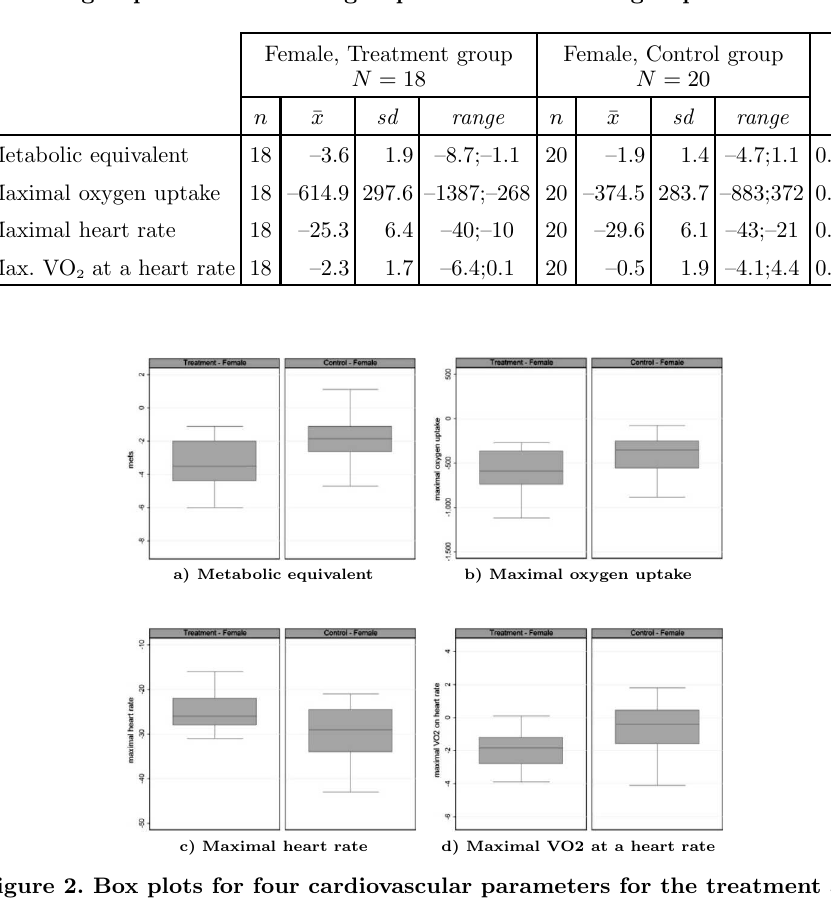
Table 3. Comparisons of cardiovascular parameters between the treatment group and the control group for the female subgroup